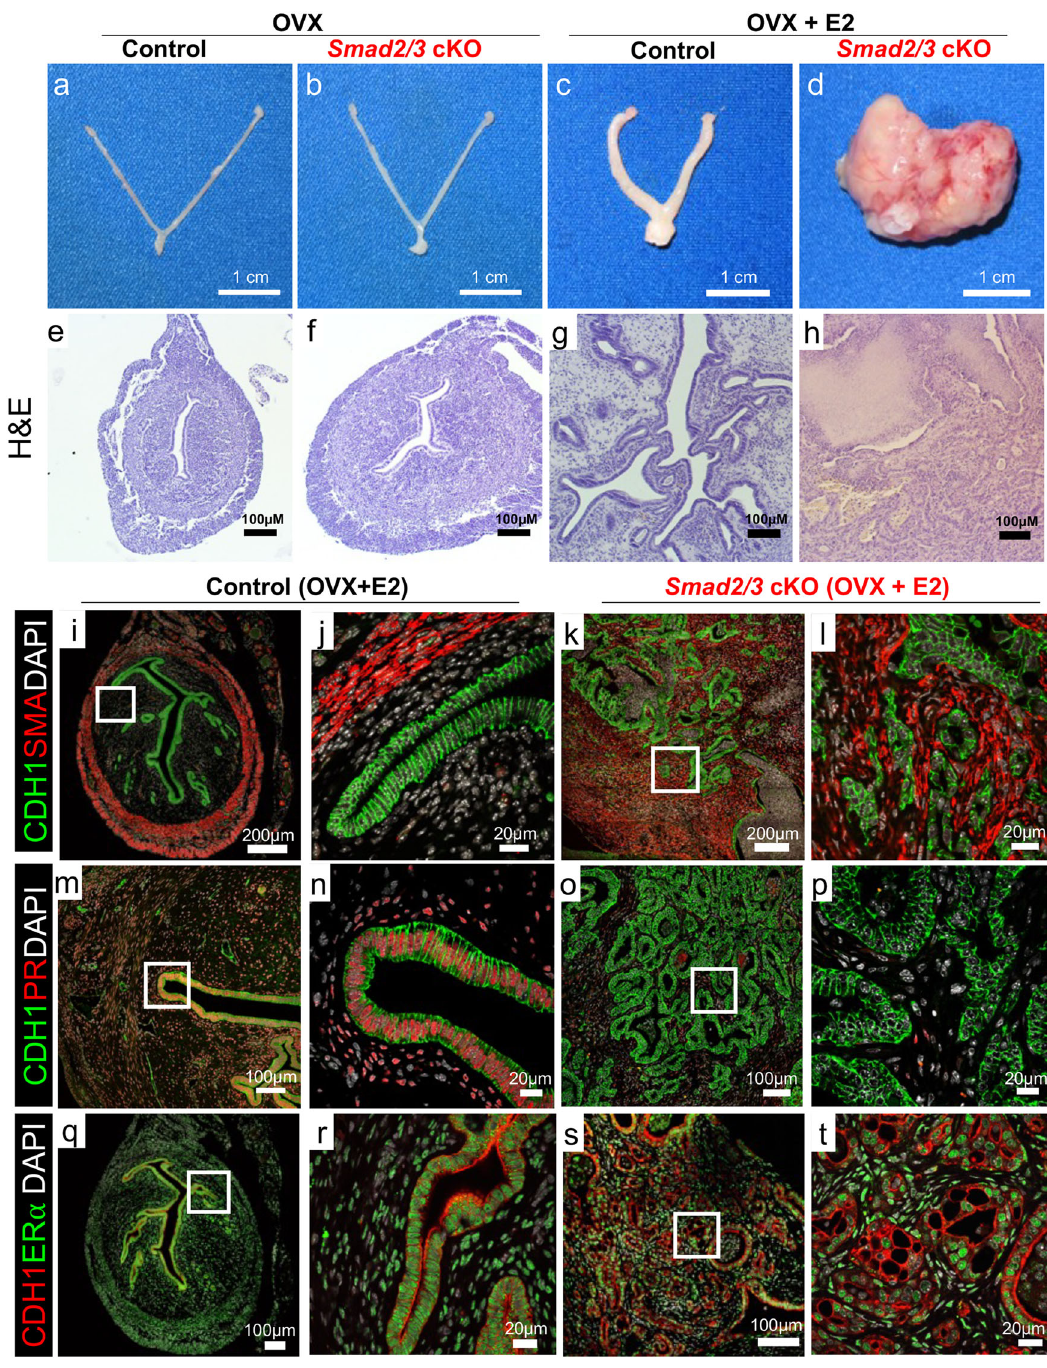
Fig. 3 Endometrial tumor development is estrogen dependent in Smad2/3 cKO mice. a – d Gross uteri from adult control ( a , c ) and Smad2/3 cKO mice ( b , d ) collected 3 months after ovariectomy (OVX) and treated without ( a , b ) or with estradiol releasing pellets ( c , d ). Only the Smad2/3 cKO mice that received the estradiol treatment developed tumors. e – h H&E stained uterine cross-sections stained of control ( e , g ) and Smad2/3 cKO ( f , h ) that were ovariectomized and treated without ( e , f ) or with estradiol ( g , h ). i – t Immunostaining of control ( i , j , m , n , q , r ) and Smad2/3 cKO mice ( k , l , o , p , s , t ) cross sections following OVX + E2 treatment. i – l Tissue sections were stained with the epithelial cell marker, E-cadherin (CDH1, green) and smooth muscle actin (SMA, red). Compared to controls ( i , j ) sections from Smad2/3 cKO mice ( k , l ) show disordered epithelial cell and smooth muscle layers. m – p Tissue sections were stained with E-cadherin (CDH1, green) and progesterone receptor (PR, red). PR can be seen in the nuclei of the control mice ( m , n ) but not in the epithelium of Smad2/3 cKO mice ( o , p ). q – t Uterine cross sections were stained with E-cadherin (CDH1, red) and estrogen receptor α (ER α , green) antibodies. Cross sections from control ( q , r ) and Smad2/3 cKO ( s , t ) mice were positive for ER α . Nuclei were stained with DAPI (white). H&E and immunostaining experiments were performed in samples from at least 3 control and 3 Smad2/3 cKO mice.